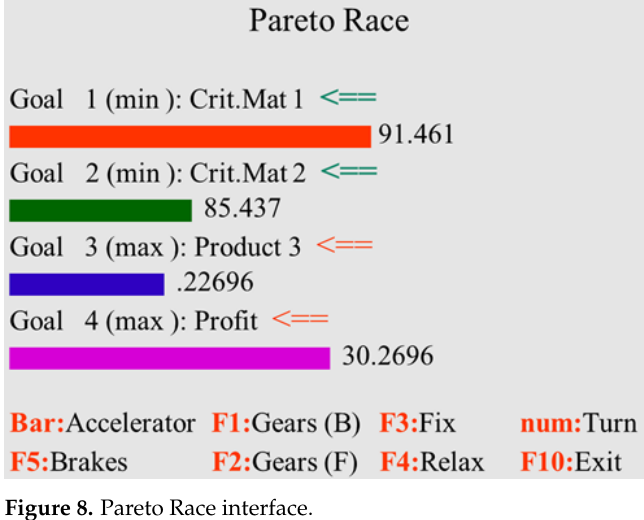
Figure 8. Pareto Race